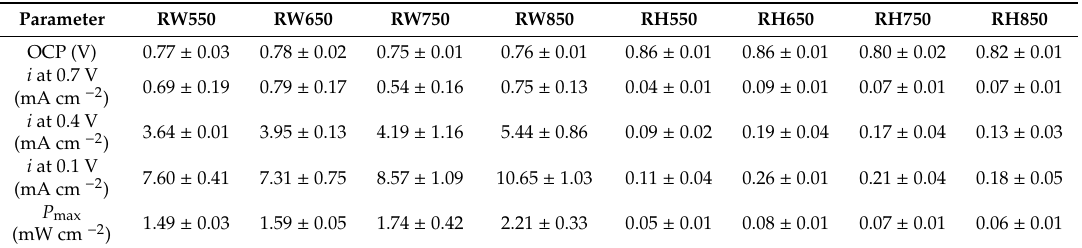
Figure 3. Polarization curves of ( a ) rice husk derived biochar, ( b ) rubber wood derived biochar from DCFC at 850 °C. Table 3. Electrochemical data for untreated rubber wood and rice husk derived biochar from DCFC at 850 °C.